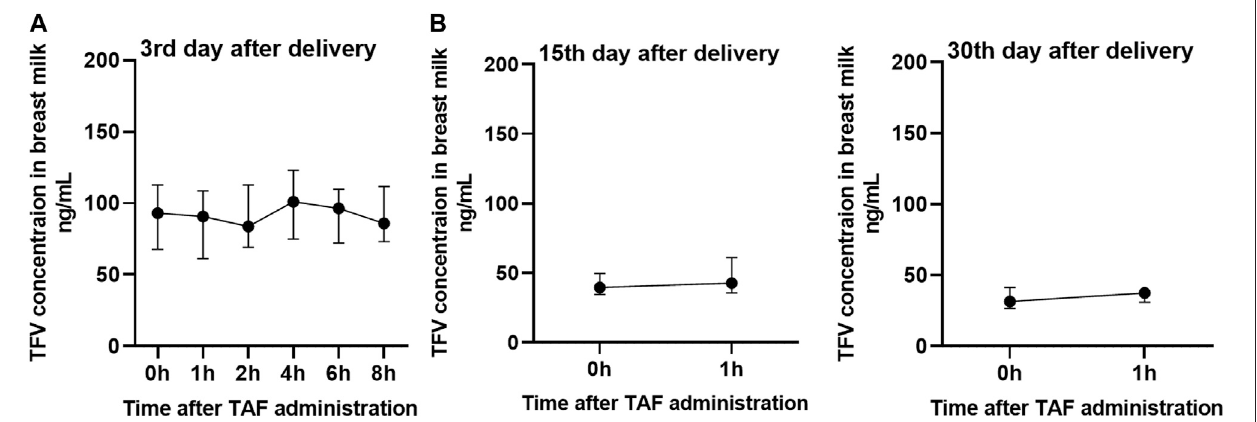
FIGURE 2 | Concentrations of TFV in the breast milk from mothers administered with 25 mg of TAF per day. Concentration-time curve of TFV in breast milk from mothers administered with TAF on the 3rd (A) , 15th (B) and 30th (C) postpartum day. Values are plotted as median (IQR). Details are presented in Table 4 .